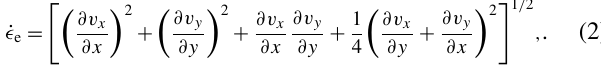
implies that the horizontal velocities do not vary in vertical ( z ) direction. The effective strain rate ˙ (cid:15) e (Greve and